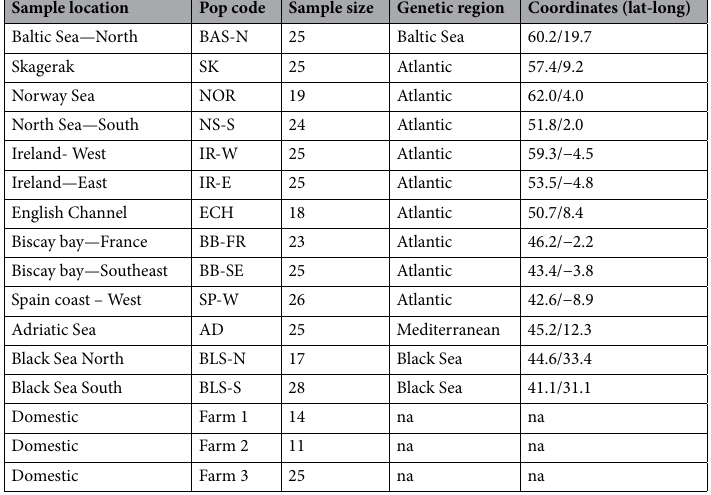
Table 1. Sampling information of turbot ( Scophthalmus maximus ). (na, not